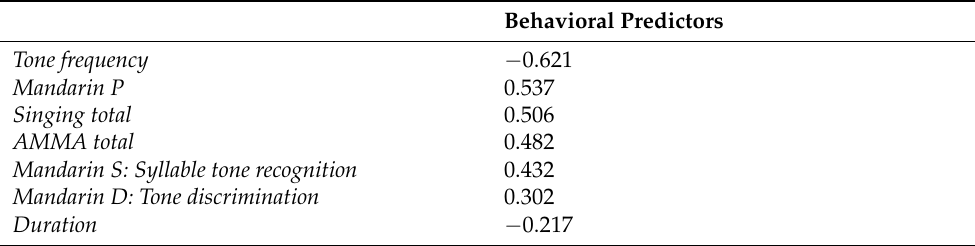
Table 4. The discriminant function of the behavioral variables. The table shows the correlations of the outcome variables and the discriminant function of the behavioral predictor variables. We used the statistically accepted cutoff value of 0.40 to decide which of the variables were large enough to discriminate between the